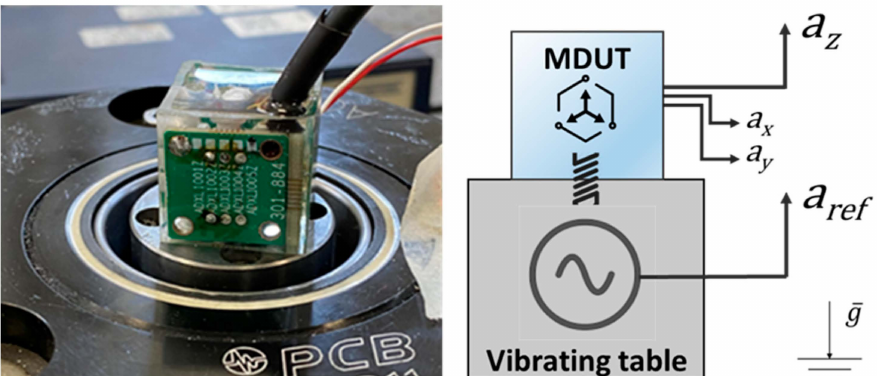
Figure 6. The vertical axial calibration of the MDUT embedded in the resin case: the MDUT on the instrumented vibrating table and a schematic picture of the calibration